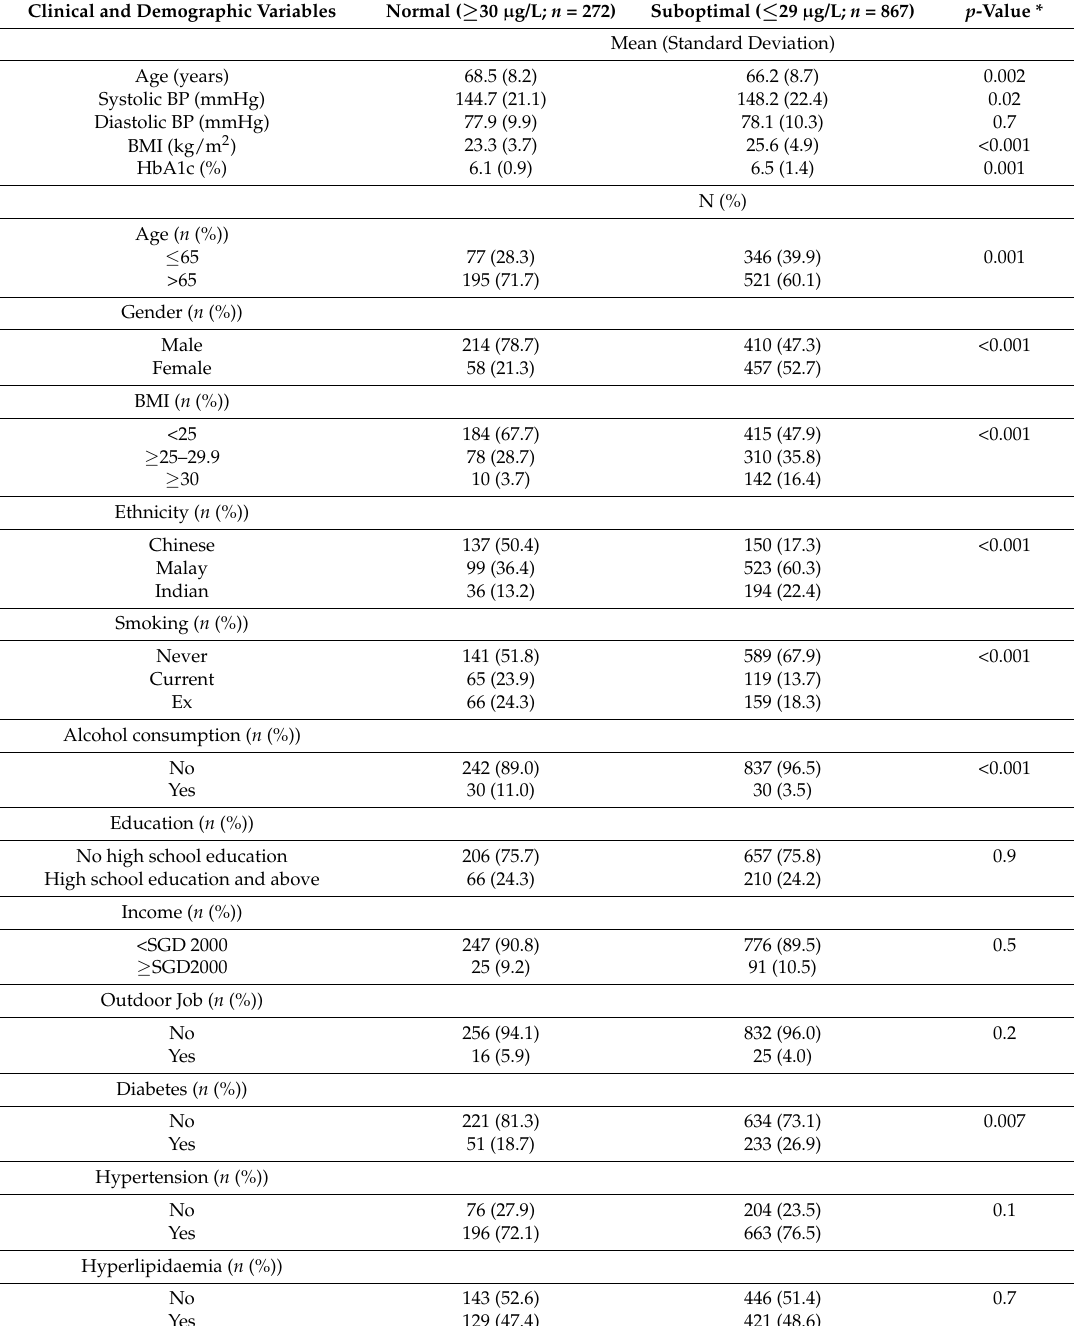
Table 1. Clinical and demographic characteristics of sample participants by plasma 25(OH)D concentration ( n =